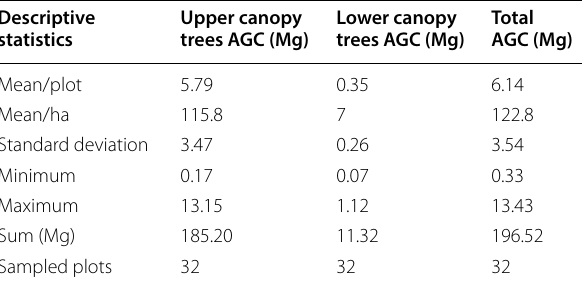
Table 6 Overall descriptive statistics of estimated above